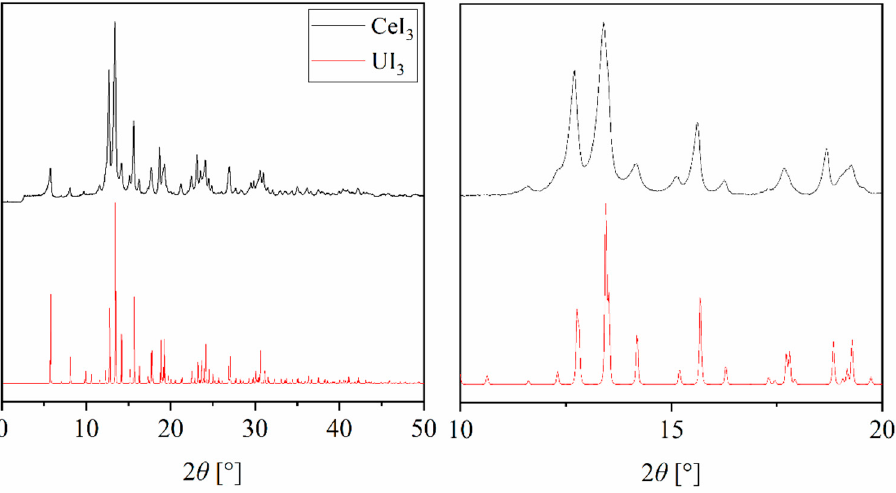
Figure 1. PXRD (full range, left; enhanced, right) of CeI 3 (black) versus the calculated isostructural UI 3 (red) [55].